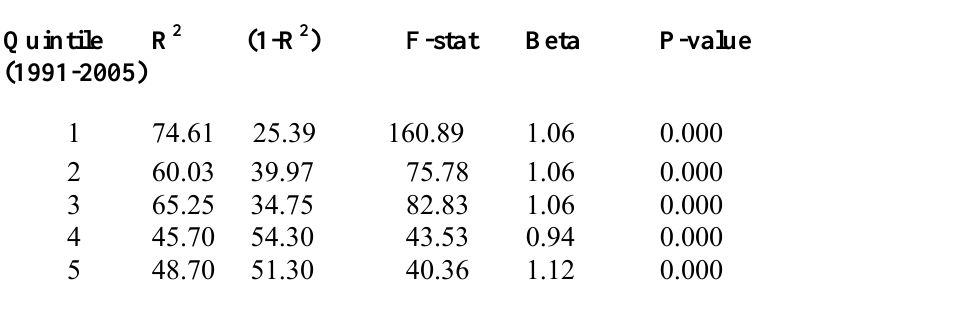
Table 3: (Maximum Proportion of) Stock-Picking in the FTSE350 by Market Capitalisation,